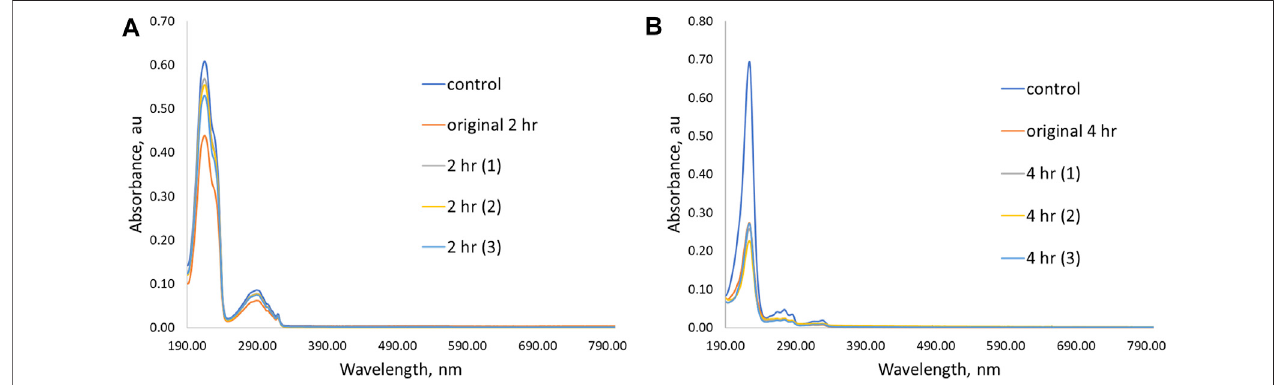
FIGURE7| UV-Visspectrashowinginitialremovalabilityandthreeadditionaltrialexperimentsfor P(4VP 3 -EGDMA 1.0 -BMA) inaqueoussolutionsof (A)PPL-HCl for 2 h and (B) 2NO for 4 h.